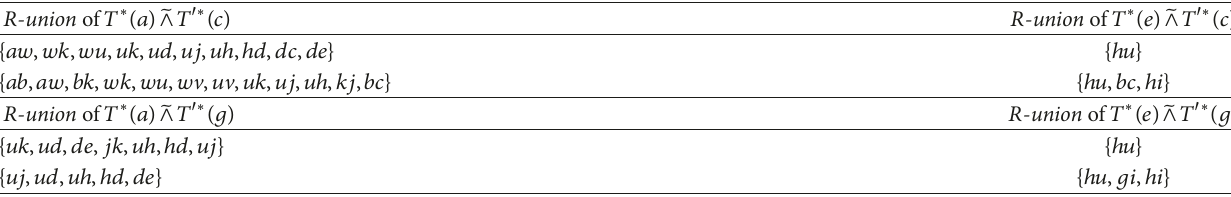
Table 5: 𝑅 - union on 𝐴∧ E 𝐵 correlation table.